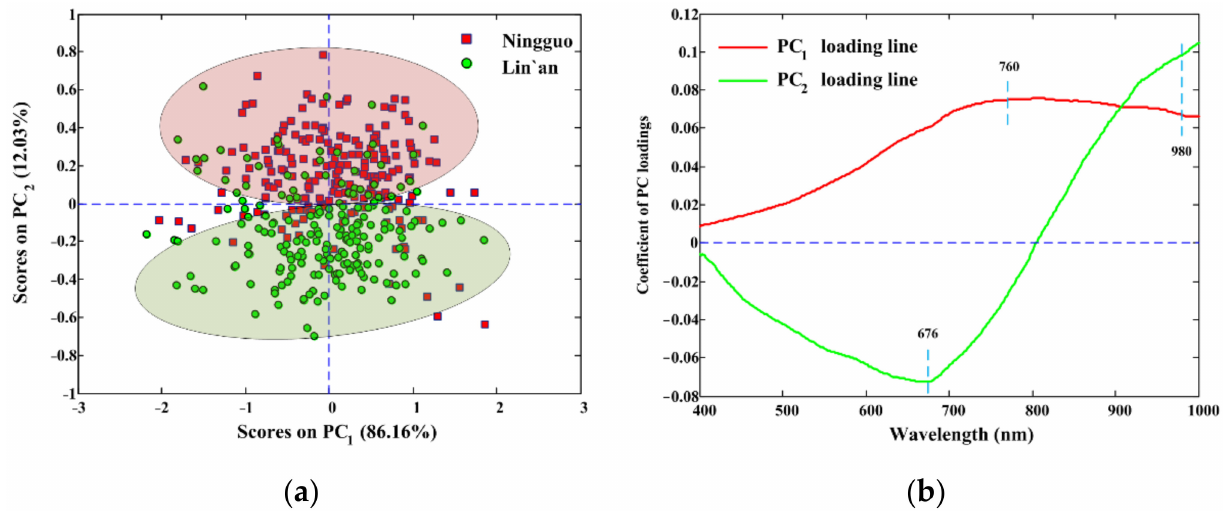
Figure 2. Spectra PCA for Chinese walnut samples of different varieties. ( a ) Score plot of PC 1 against PC 2 , ( b ) PC 1 and PC 2 loading lines. PCA: principal component analysis; PC 1 : first principal component; PC 2 : second principal